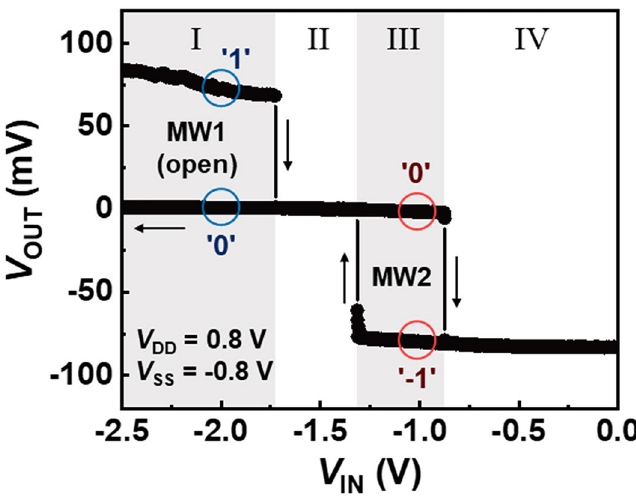
Figure 4. Voltage hysteresis characteristics of the proposed ternary inverter, indicating two different MWs (MW1 and